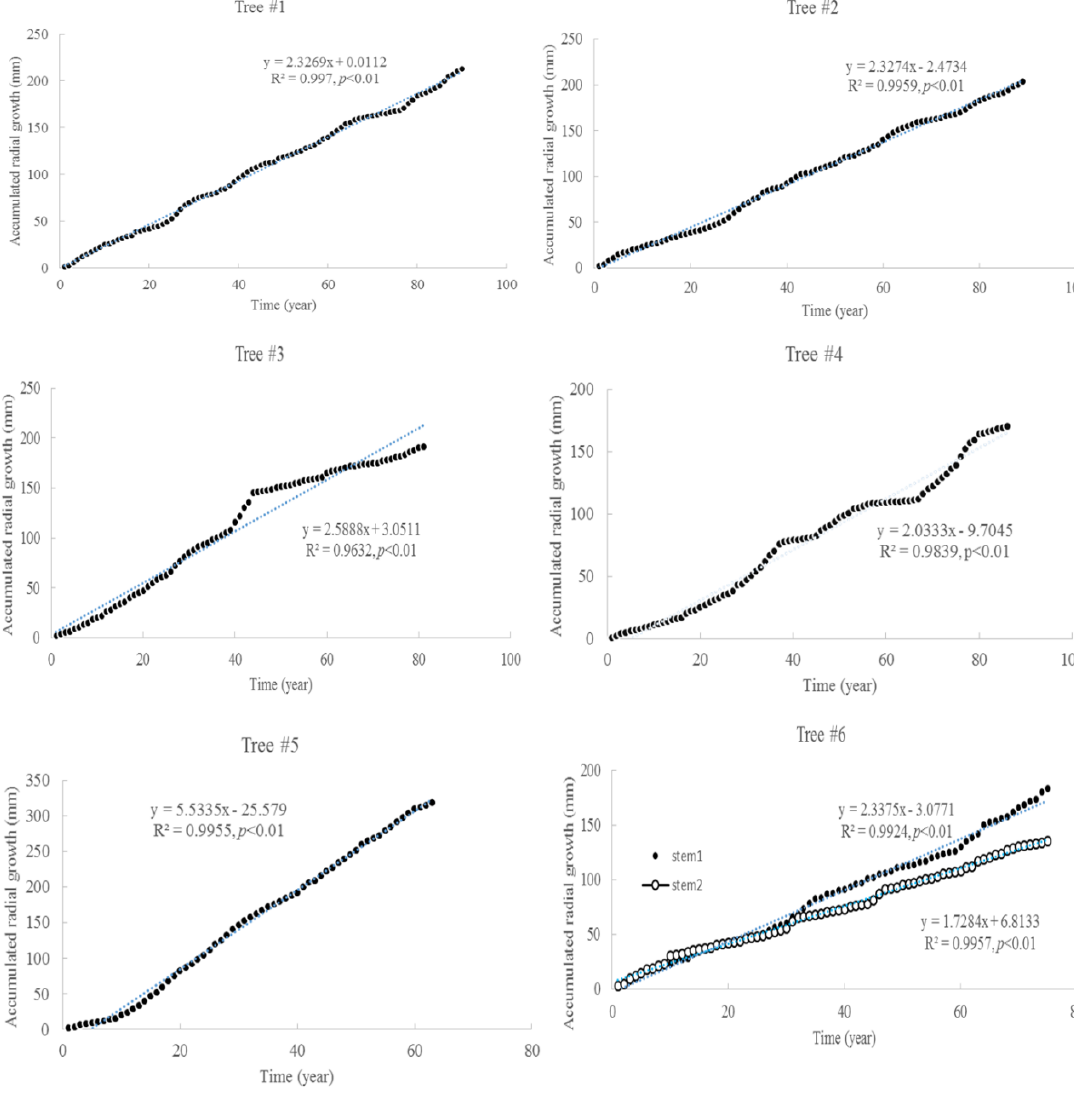
Figure 1. Accumulated radial growth with time for six Chinese Torreya trees.